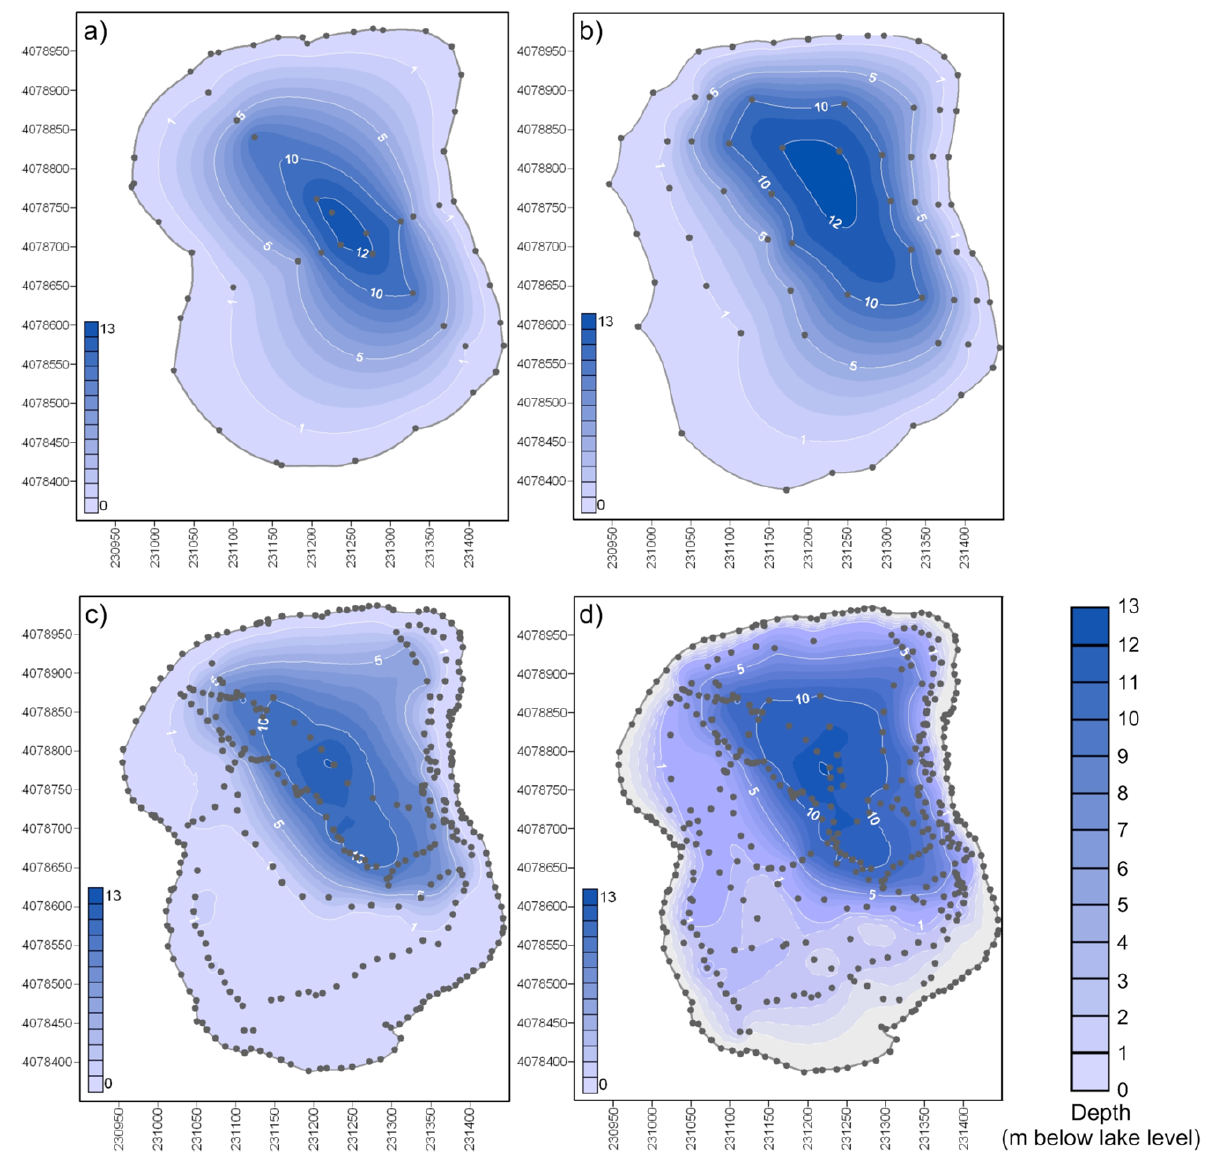
Figure 4. Morphobathymetric maps of Lake Specchio di Venere: a) Survey after Bocchi et al. [1988]; b) Survey after Aiuppa et al. [2007]; c) 2007 survey; d) 2009 survey. Coordinates expressed in UTM-WGS1984 system and referred to 33S Zone. Dark circles are the measurement